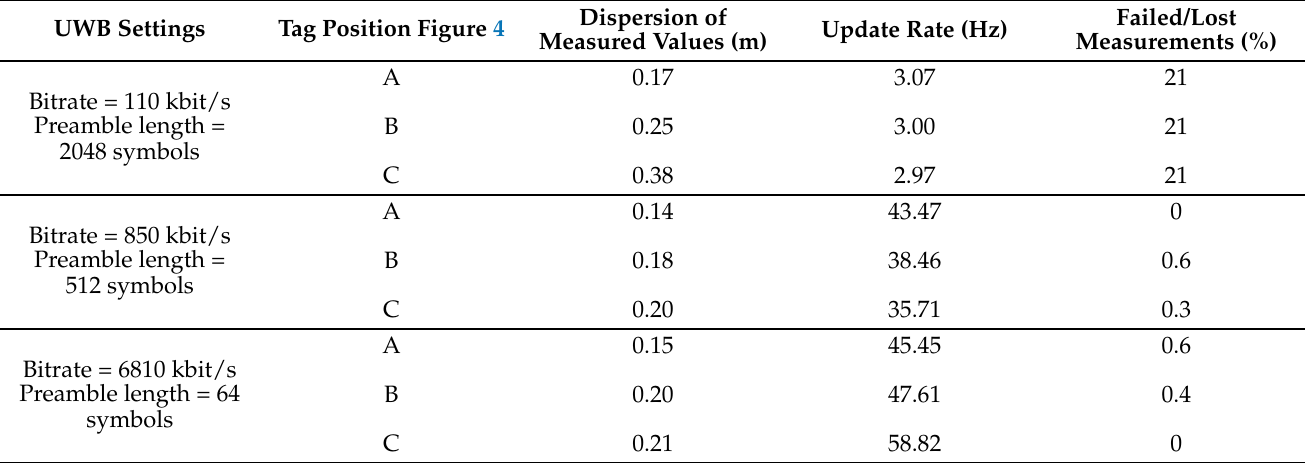
Figure 4. Test workplace floor plan. The red colour represents the danger zone, the yellow colour represents the warning zone, and the green colour represents the safe zone. ( 1 ) Depth camera. ( 2 ) RTLS anchors. ( 3 ) Robotic workplace. ( A – C ) RTLS measurement point, Table 3. Table 3. RTLS accuracy based on the tag position within the test